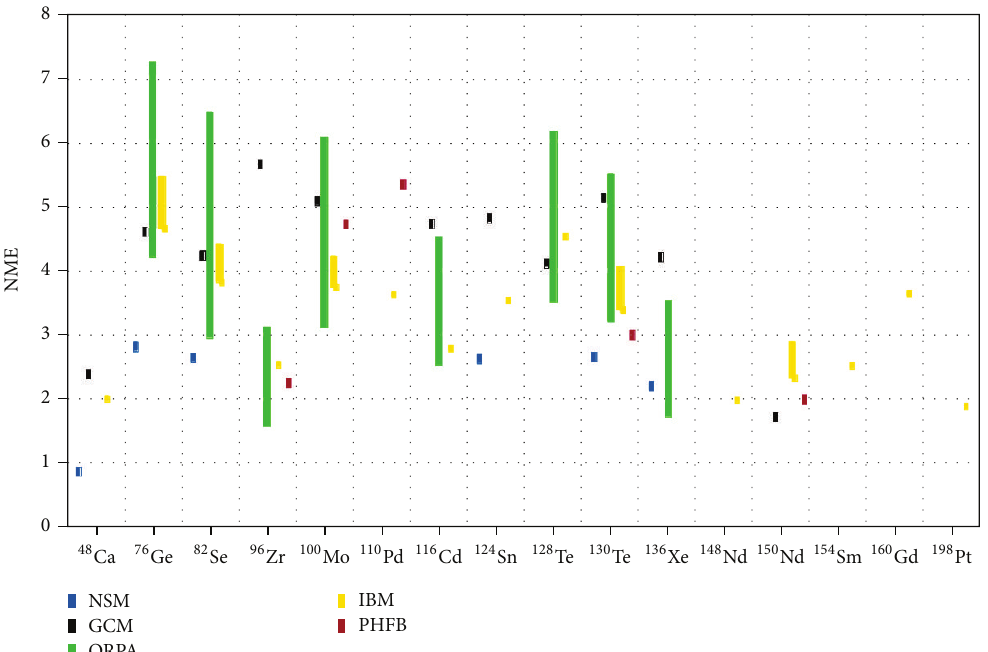
Figure 2: 𝛽𝛽(0 ] ) NME calculations as reported in Table 2.